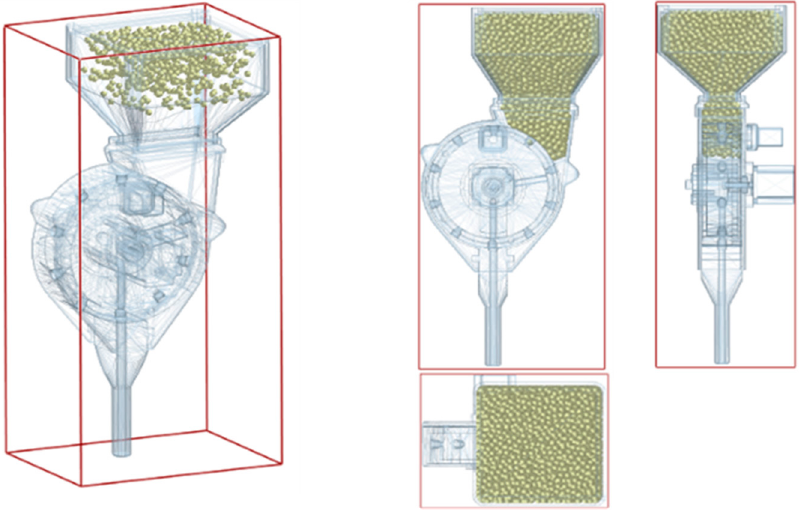
Figure 11. Calculation model of the seed sowing device.